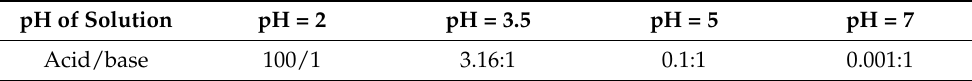
Table A2. Example of [acid]/[base] ratio for Diclofenac at various pH values.